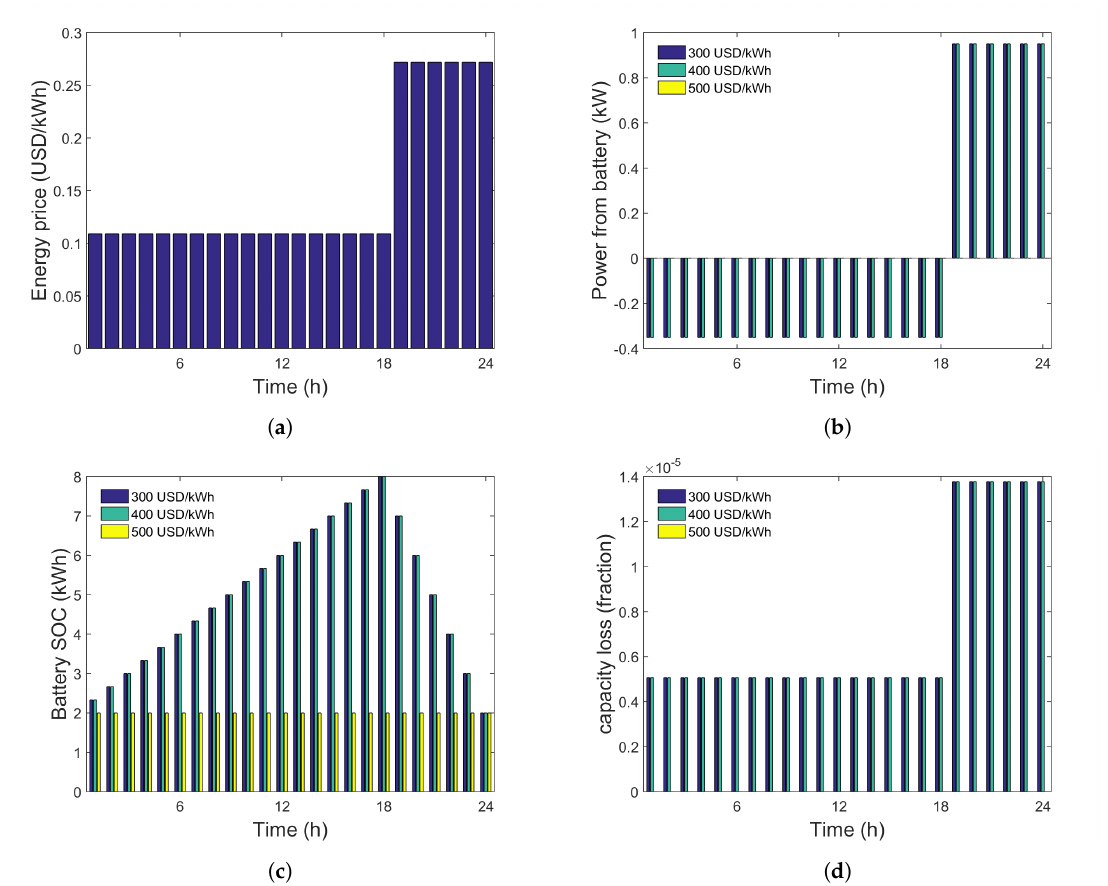
Figure 2. Optimal operation for a “simple tariff” example during a 24 h period. ( a ) Electricity TOU tariff for Uruguay. ( b ) Optimal power consumed ( p C , represented as negative for visual purposes) and t supplied ( p D ) by the battery. ( c ) Battery State of Charge at each time ( soc t ). ( d ) Fraction of capacity t lost by the battery at each time ( x CL ). Accumulated fraction loss in one day is 1.7 × 10 − 4 for 300 and t 400